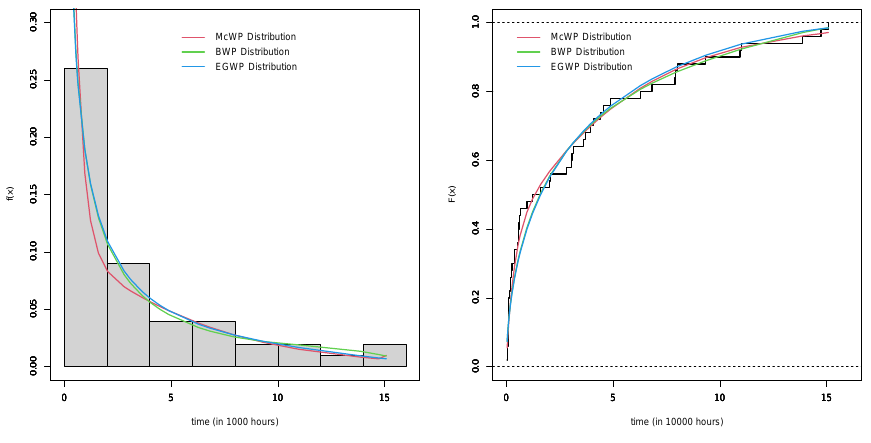
Figure 7 – Fitted PDF (left panel) and CDF (right panel) of McWP, BWP, and EGWP distribution for repair time